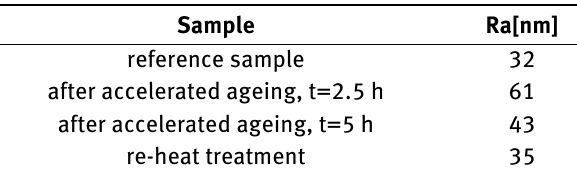
Table 5: Measured surface roughness (Ra) of accelerating aged